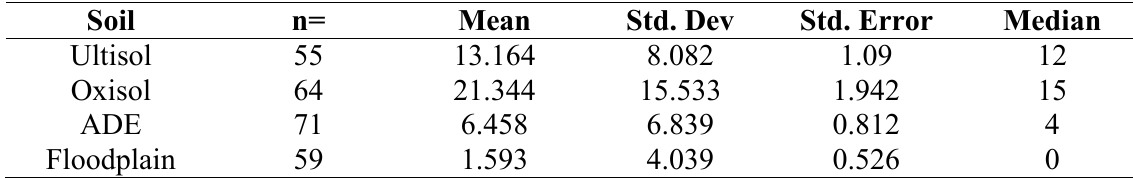
Table 6. Descriptive statistics for ages of vegetation (in years) cleared in 59 floodplain, 71 ADE, 64 Oxisol, and 55 Ultisol fields along the middle Madeira River.